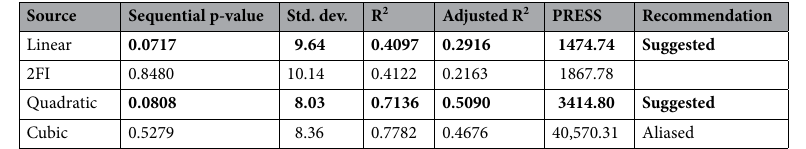
Table 14. Model summary statistics of exploitation zone for QAM f steel. Significant values are in bold.